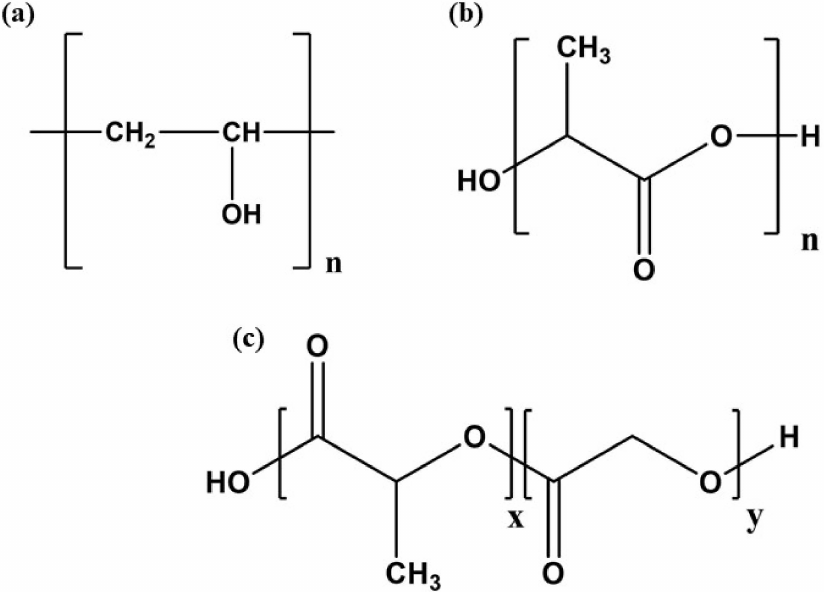
Figure 2. Chemical structure of synthetic polymers ( a ) Polyvinyl alcohol (PVA), ( b ) Polylactic acid (PLA), and ( c ) Poly(lactic-co-glycolic) acid (PLGA).